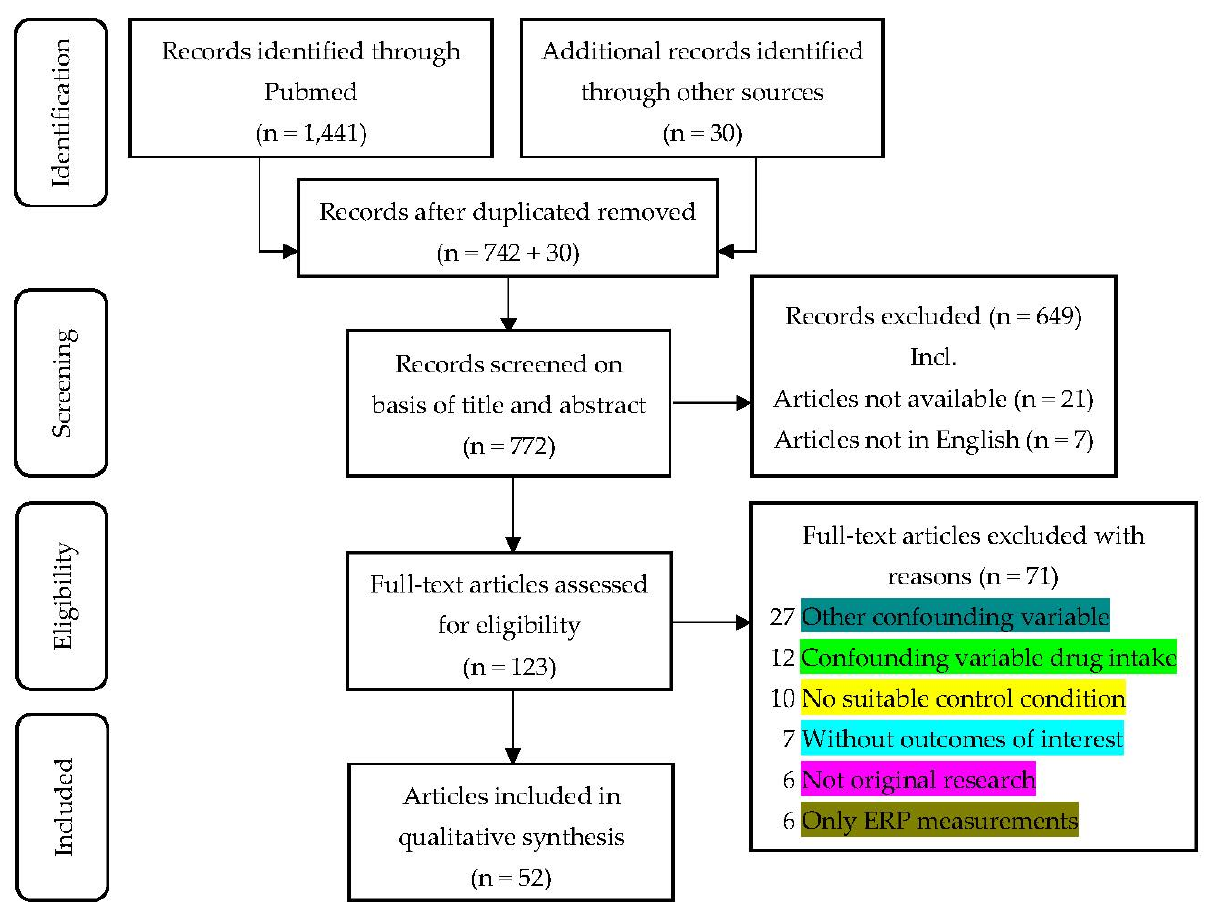
Figure 1. Flow diagram of article selection (The color coding refers to the classification and is picked up again in Table A1).